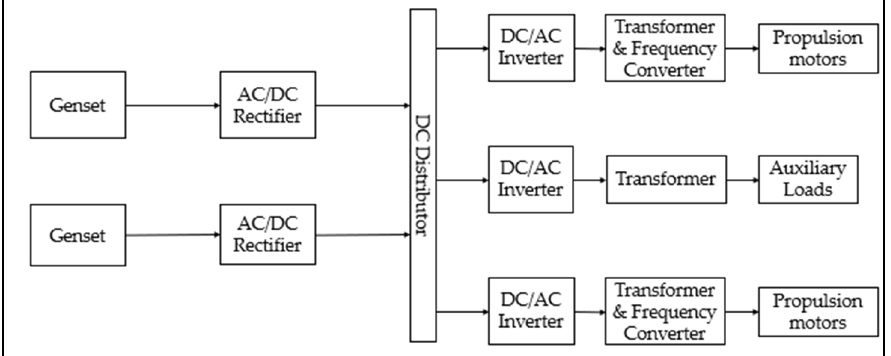
Figure 3. Simplified power flow of hybrid fully electric vessel power system.